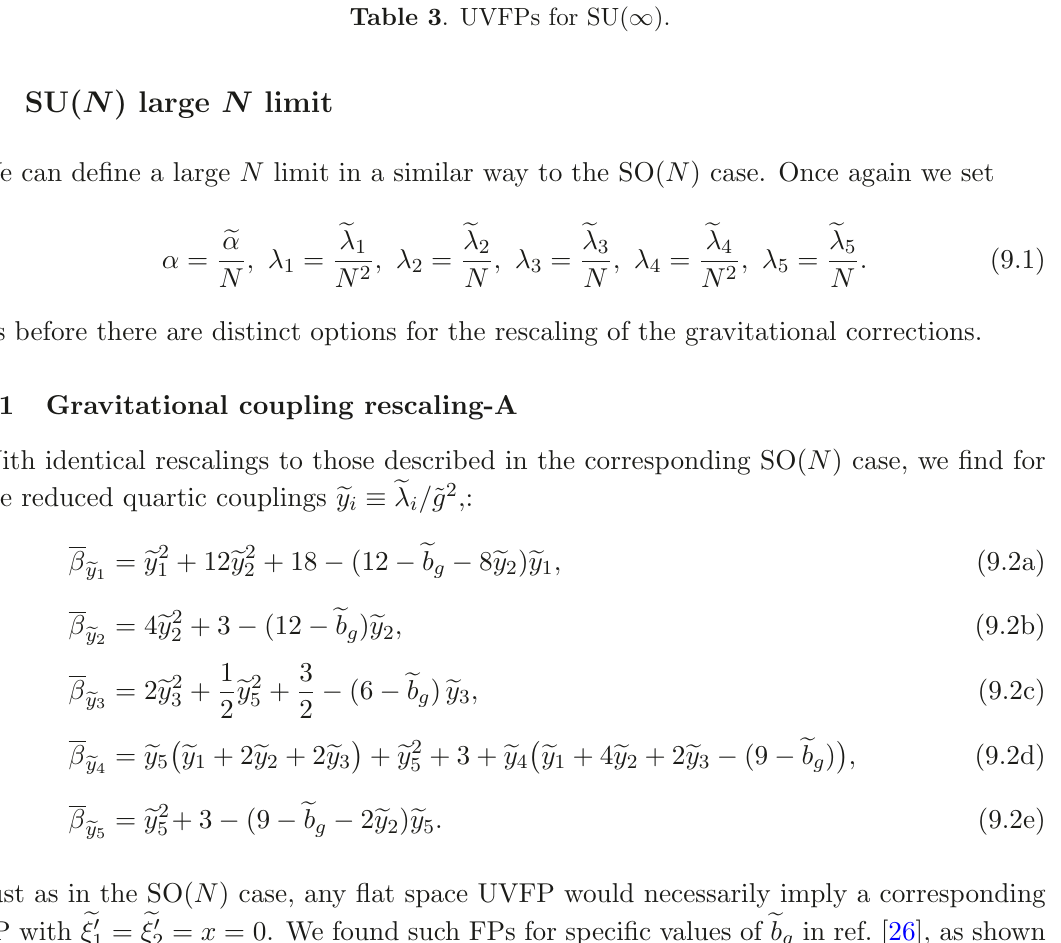
Table 3 . UVFPs for SU(